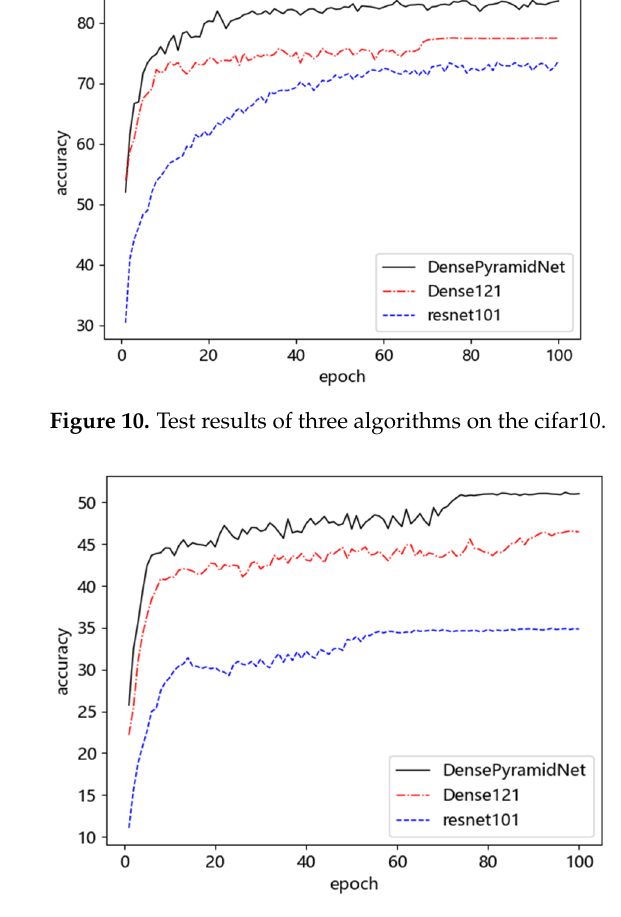
Figure 11. Test results of three algorithms on the cifar100.